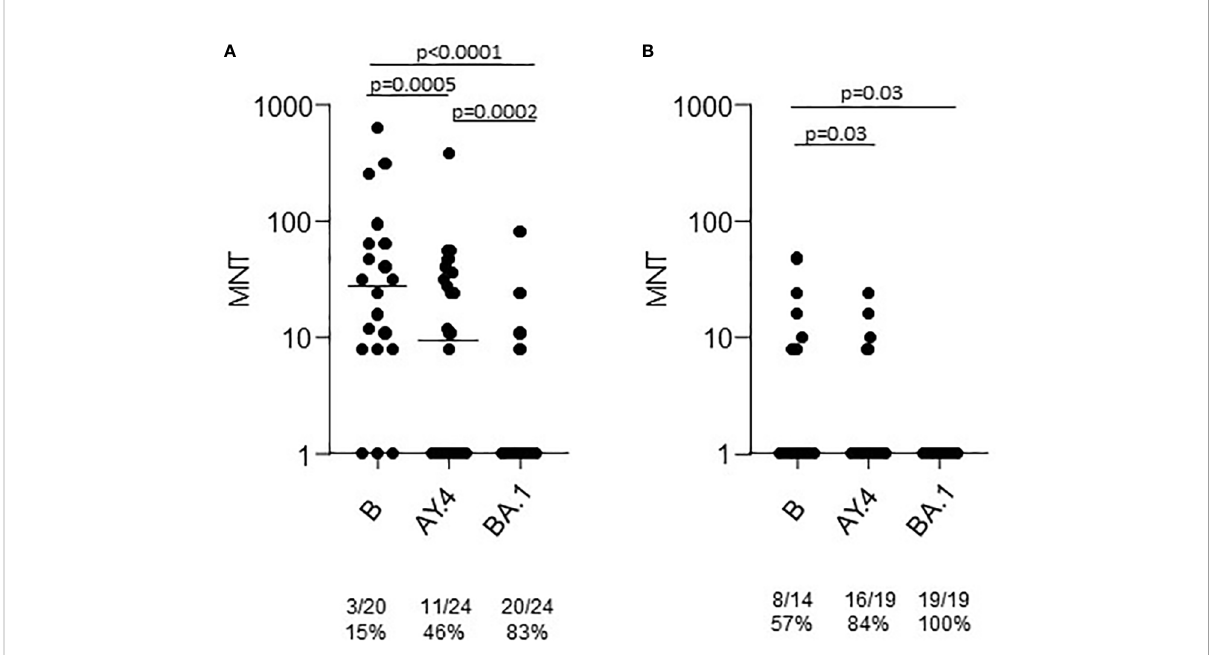
FIGURE 3 Microneutralization titers of T2 sera from COVID-19 naïve subjects vaccinated with Comirnaty. Sera from healthy adults (A) and frail elderly subjects (B) vaccinated with the Comirnaty vaccine were used to neutralize reference SARS-CoV-2 strain (B), a Delta strain (AY.4) and an Omicron strain (BA.1). Individual MNT are reported together with median values. Non-neutralizing sera (MNT<8) are placed on the x-axis; frequencies of non-neutralizing sera are indicated below the graphs. Statistical differences among strains were calculated by the Kruskall-Wallis